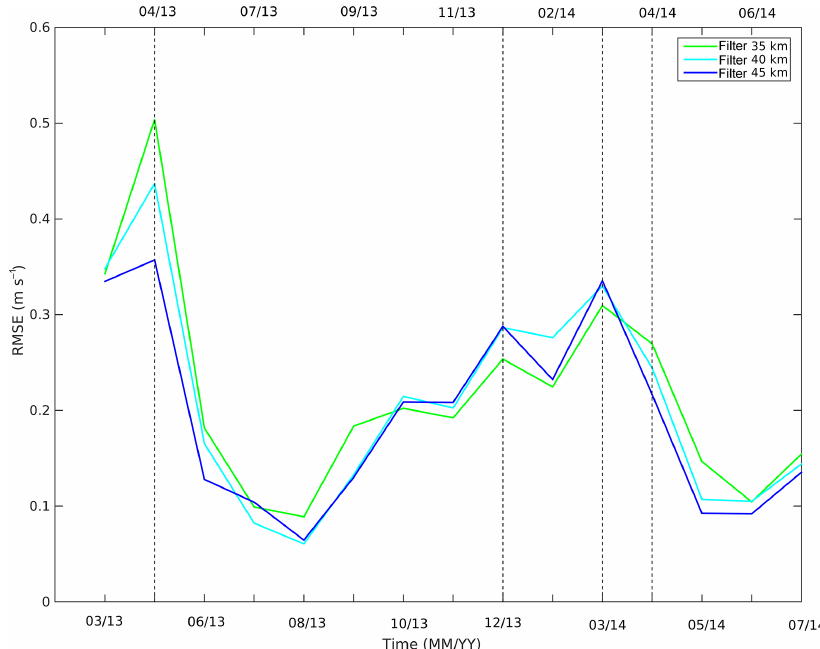
Figure 12. RMSE between the cross-track HF radar current amplitudes and the SARAL current amplitudes. Dates with low correlations (<0.5) are marked with the vertical dashed